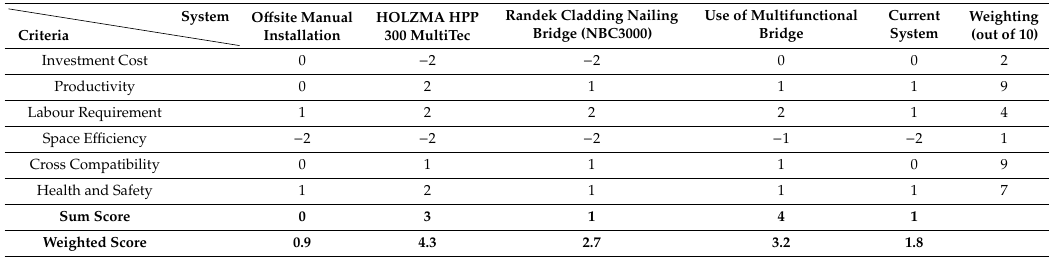
Table 10. Resultant scores for facade